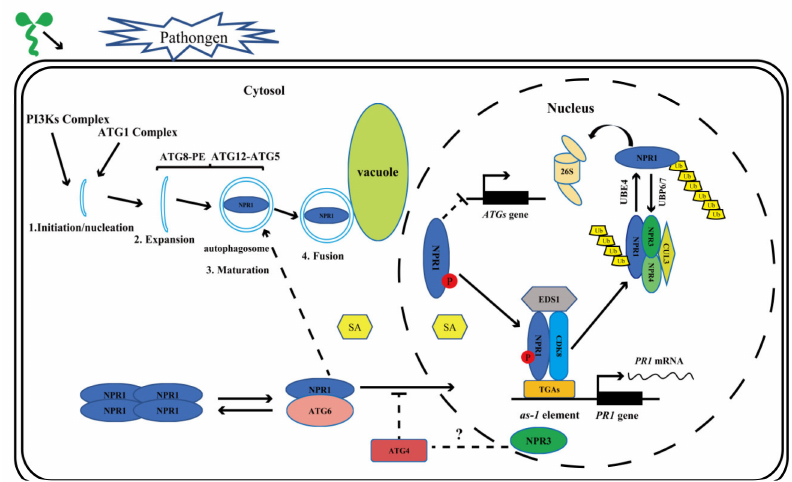
Figure 1. Pattern diagram of autophagy involved in NPR1 regulation in Arabidopsis . Autophagy pathway can be divided into four stages: initiation, expansion, maturation, and fusion. Normally, NPR1 exists in the cytoplasm as an oligomer. Upon pathogen infection, SA accumulates in the plant cell. NPR1 was phosphorylated and transferred from cytoplasm to nucleus. In the nucleus, NPR1 forms a protein complex with CDK8 and EDS1, promoting the expression of the PR1 gene. NPR1 is degraded by the 26S proteasome complex through a series of polyubiquitination processes by CUL3 and UBE4, and its deubiquitination is mediated by UBP6 and UBP7, which are closely linked to 26S proteasome. It is reasonable to speculate that ATG6 may promote the entry of NPR1 into the nucleus, while ATG4 may have the opposite